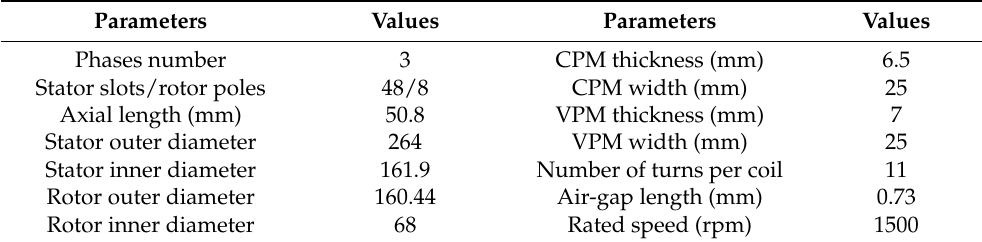
Figure 1. Motor topology. ( a ) Forward parallel structure; ( b ) reverse parallel structure. Table 1. Motor parameters.